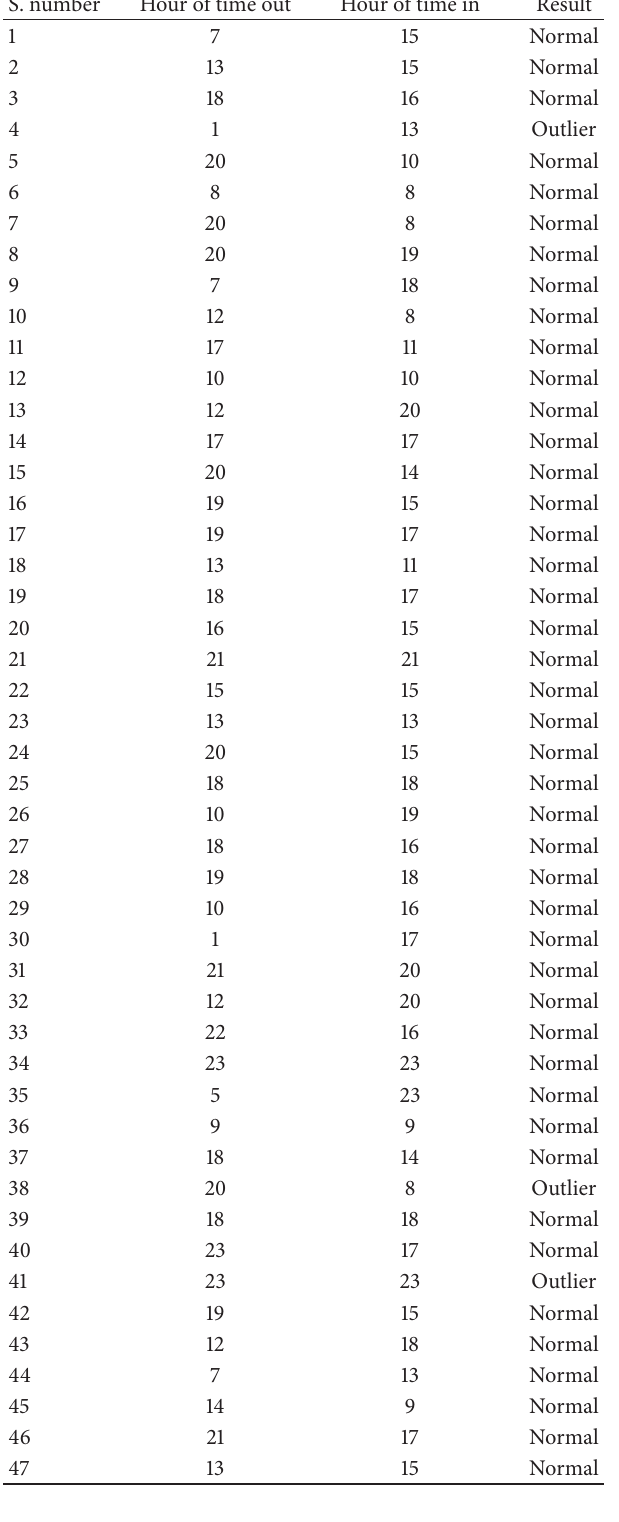
Table 10: Outlier detection results on cyber attackers network. S.